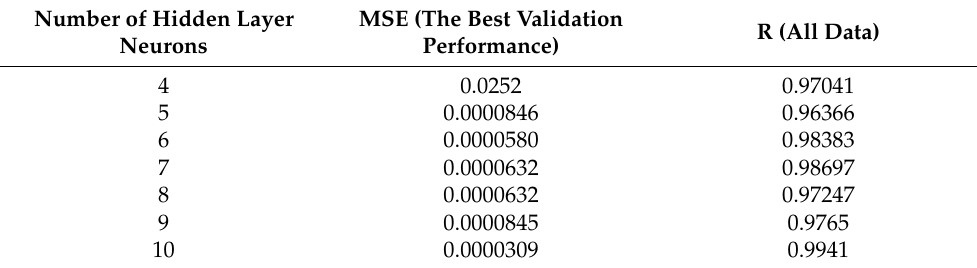
Table 4. Comparison of results for different numbers of neurons in hidden layers.